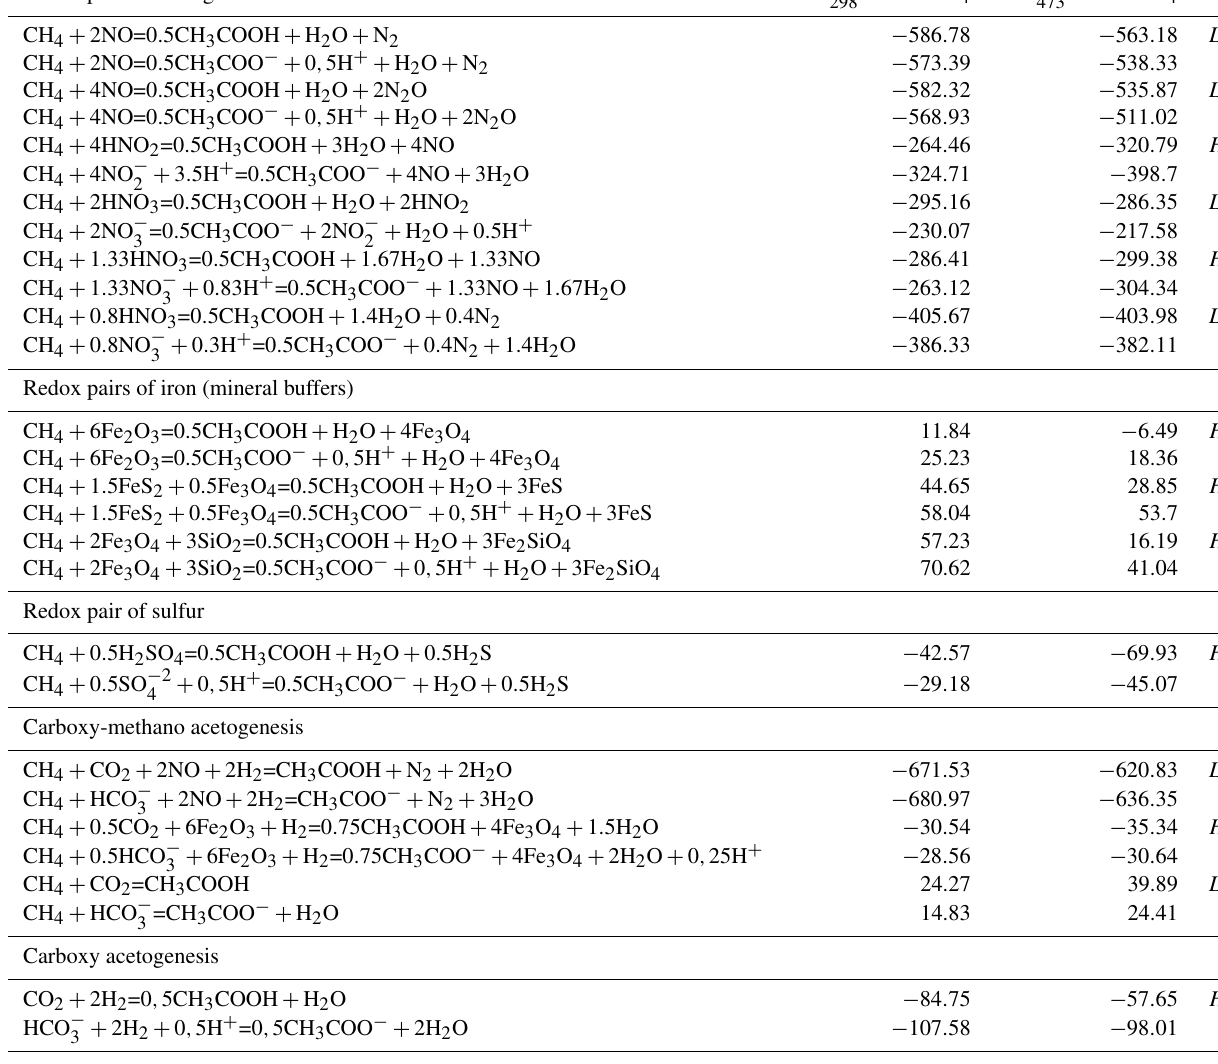
Table 1. Free Gibbs energy of aqueous reactions of anaerobic methanotrophic acetogenesis at 298 and 473K at the saturated vapor pressure ( P SAT ). The oxidized and reduced states of oxidant in the reaction are conditionally called the redox pairs. The oxidation of methane to fully ionized and non-ionized forms of acetate is presented. Value of (cid:49)G 0 at 298 and 473K indicates the advantage of the reactions at low ( L ) or T high ( H ) temperatures. Free energies of aqueous substances formation at P SAT (Amend and Shock, 2001) were used in calculations. Redox pairs of